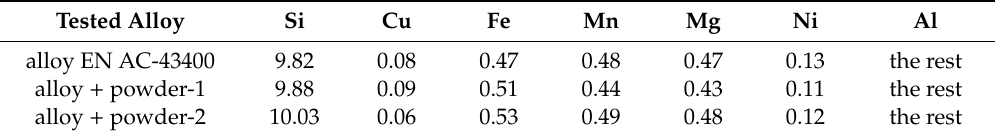
Table 1. Chemical composition of tested alloy AlSi10Mg0.5Mn0.5 before and after introduction of the powder (%mass).